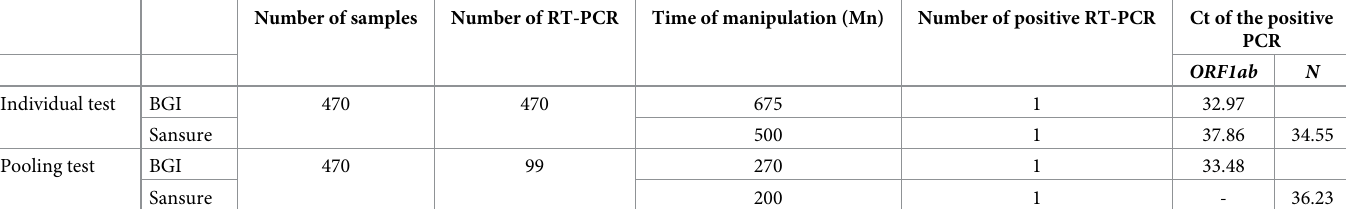
Table 4. Comparative resource, time and result requirements between individual and pooled samples testing according to the BGI and Sansure-Biotech RT-PCR